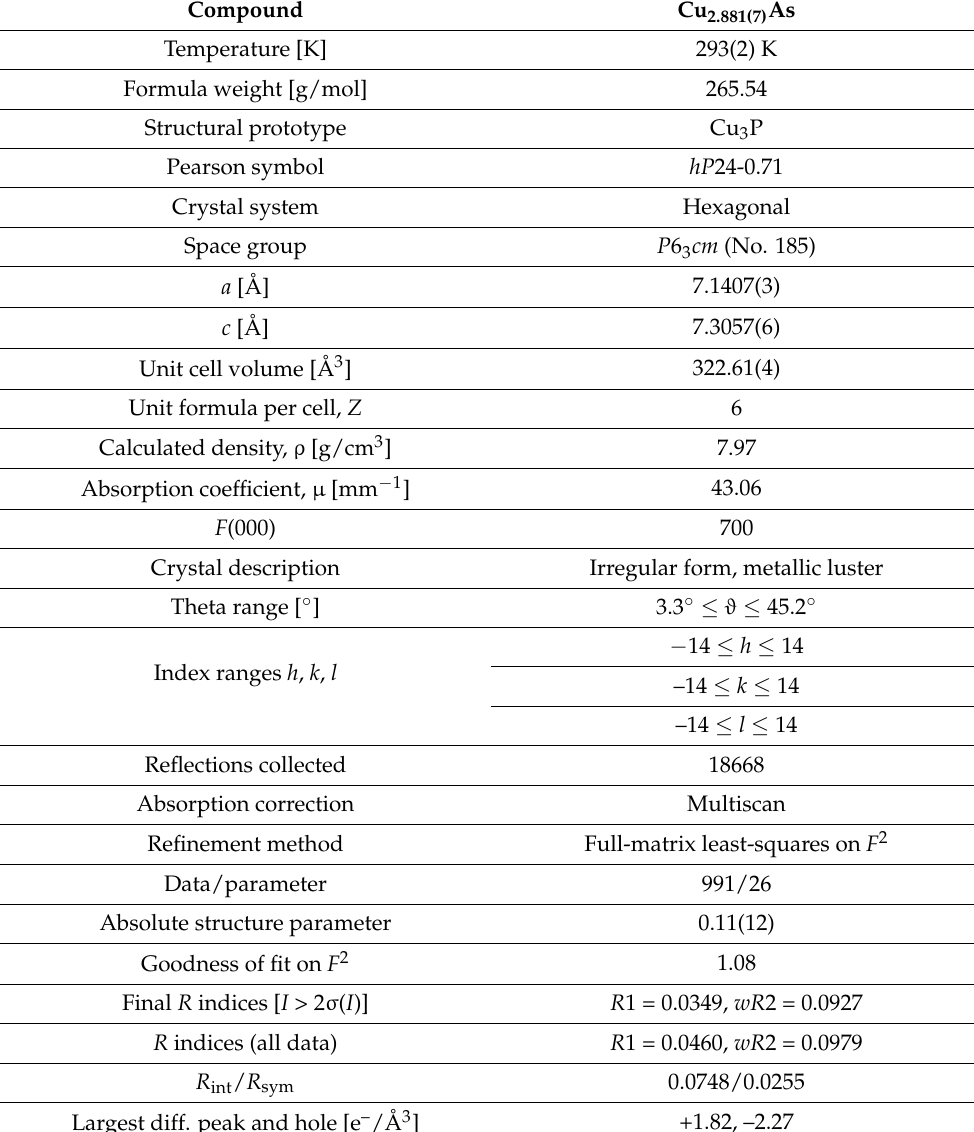
Table 1. Crystal data and structure refinement details for the RT-Cu 3 − x As compound.